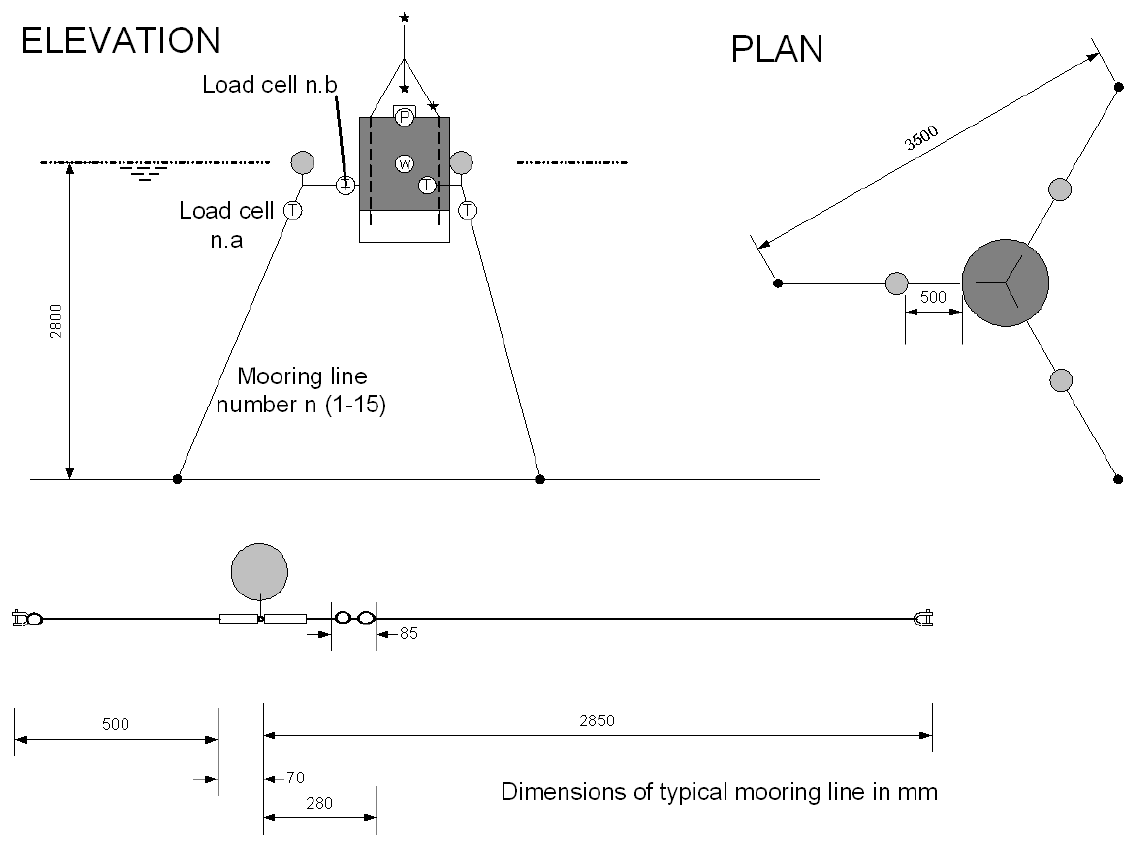
Figure 3. Arrangement and dimensions of mooring